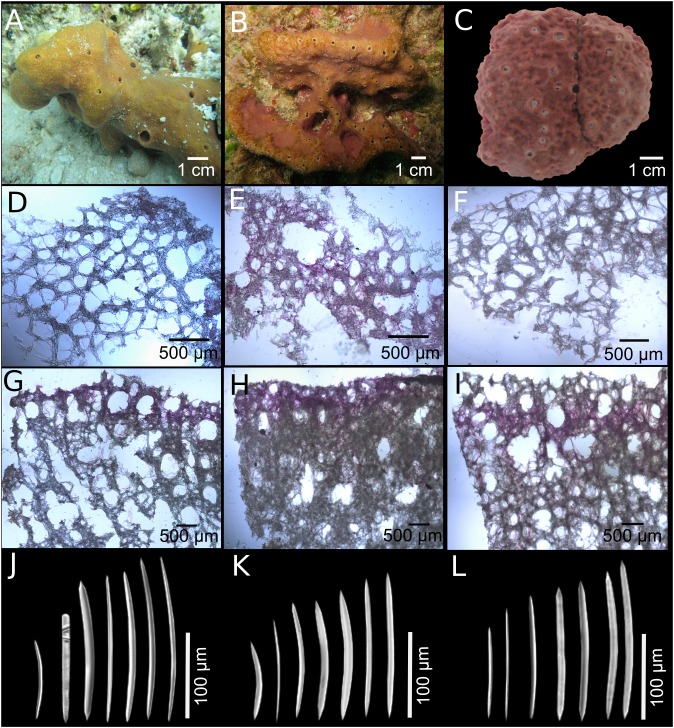
Neopetrosia proxima
Duchassaing De Fonbressin & Michelotti, 1864.In situ images of Panama specimens (A) UF 3856, (B) UF 3858, and ex situ image of (C) UF 3860, with corresponding images of (D–F) tangential sections of the ectosome (LM); (G–I) perpendicular sections through the ectosome and choanosome (LM); (J–L) size and morphological variations of oxeas (SEM).